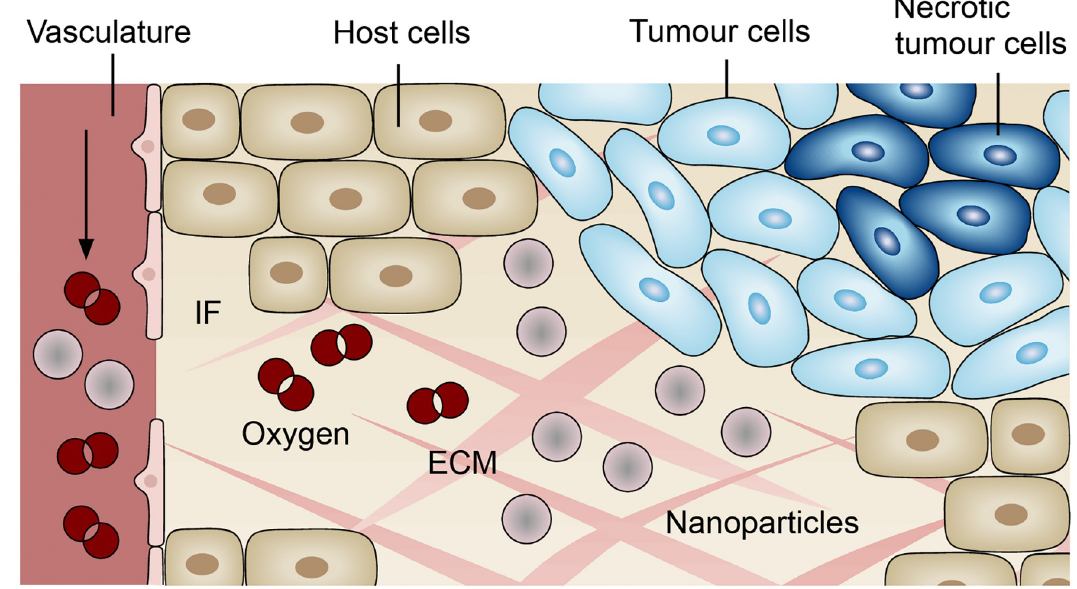
Fig 1. Components of the multiphase tumour growth model. The model comprises a solid phase, the ECM, three fluid phases, host cells, tumour cells and interstitial fluid (IF), and the vasculature which is modelled as an independent porous network. In addition, the phases transport species, namely necrotic tumour cells, oxygen and